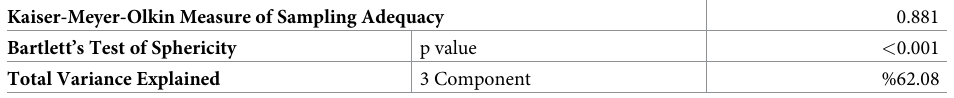
Table 3. Kaiser-Meyer-Olkin test, Bartlett’s test and total variance explained results for exploratory factor analysis. Kaiser-Meyer-Olkin Measure of Sampling